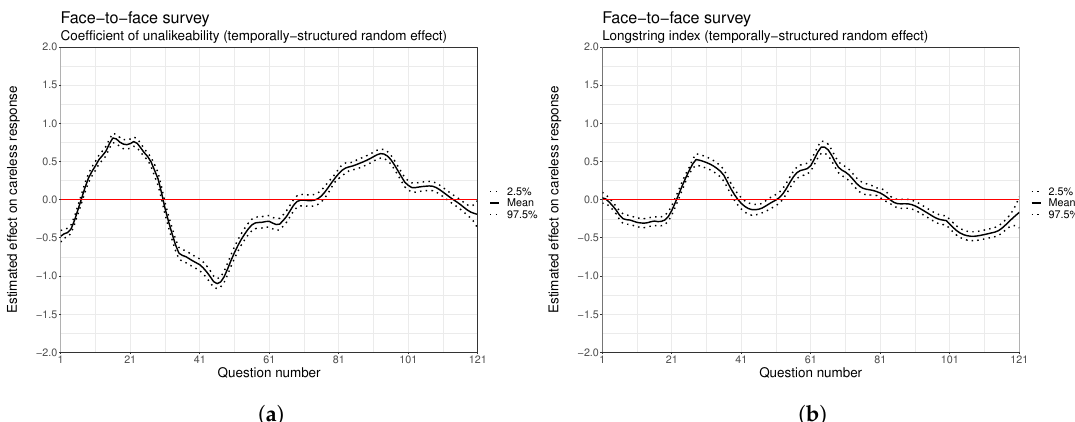
Figure 5. Estimation of the structured temporal random effect included for modeling careless response rates in the face-to- face survey by considering the coefficient of unalikeability ( a ) and the longstring index ( b ). These estimates correspond to ˆ γ j according to Equation (4) ( a ) and Equation 5 ( b ).